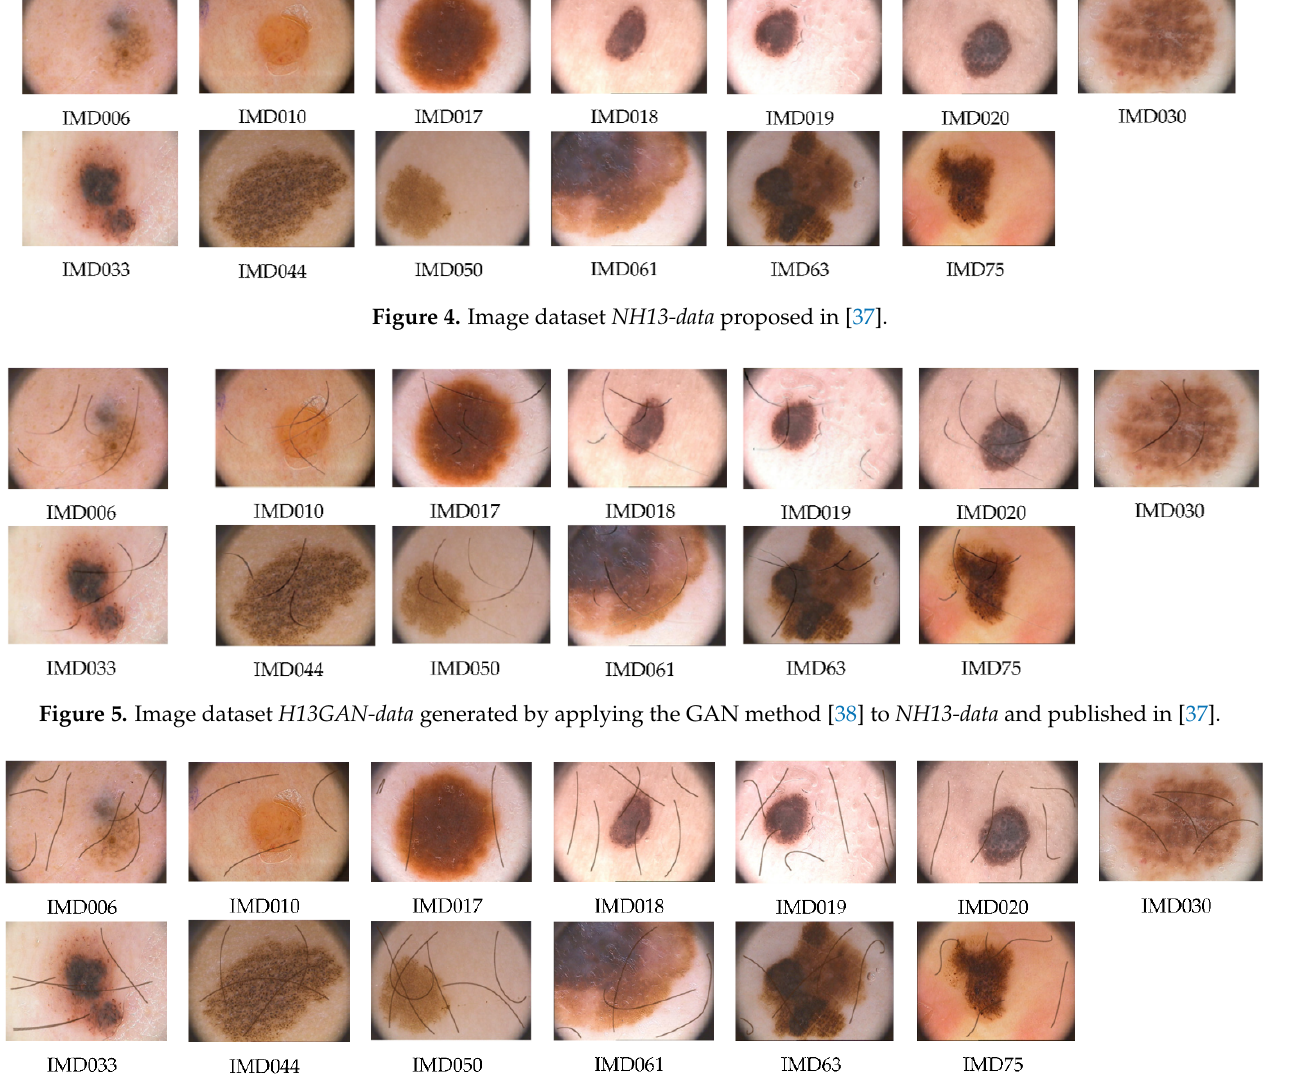
Figure 6. Image dataset H13Sim-data generated by applying the HairSim method [39] to NH13-data and published in [37].